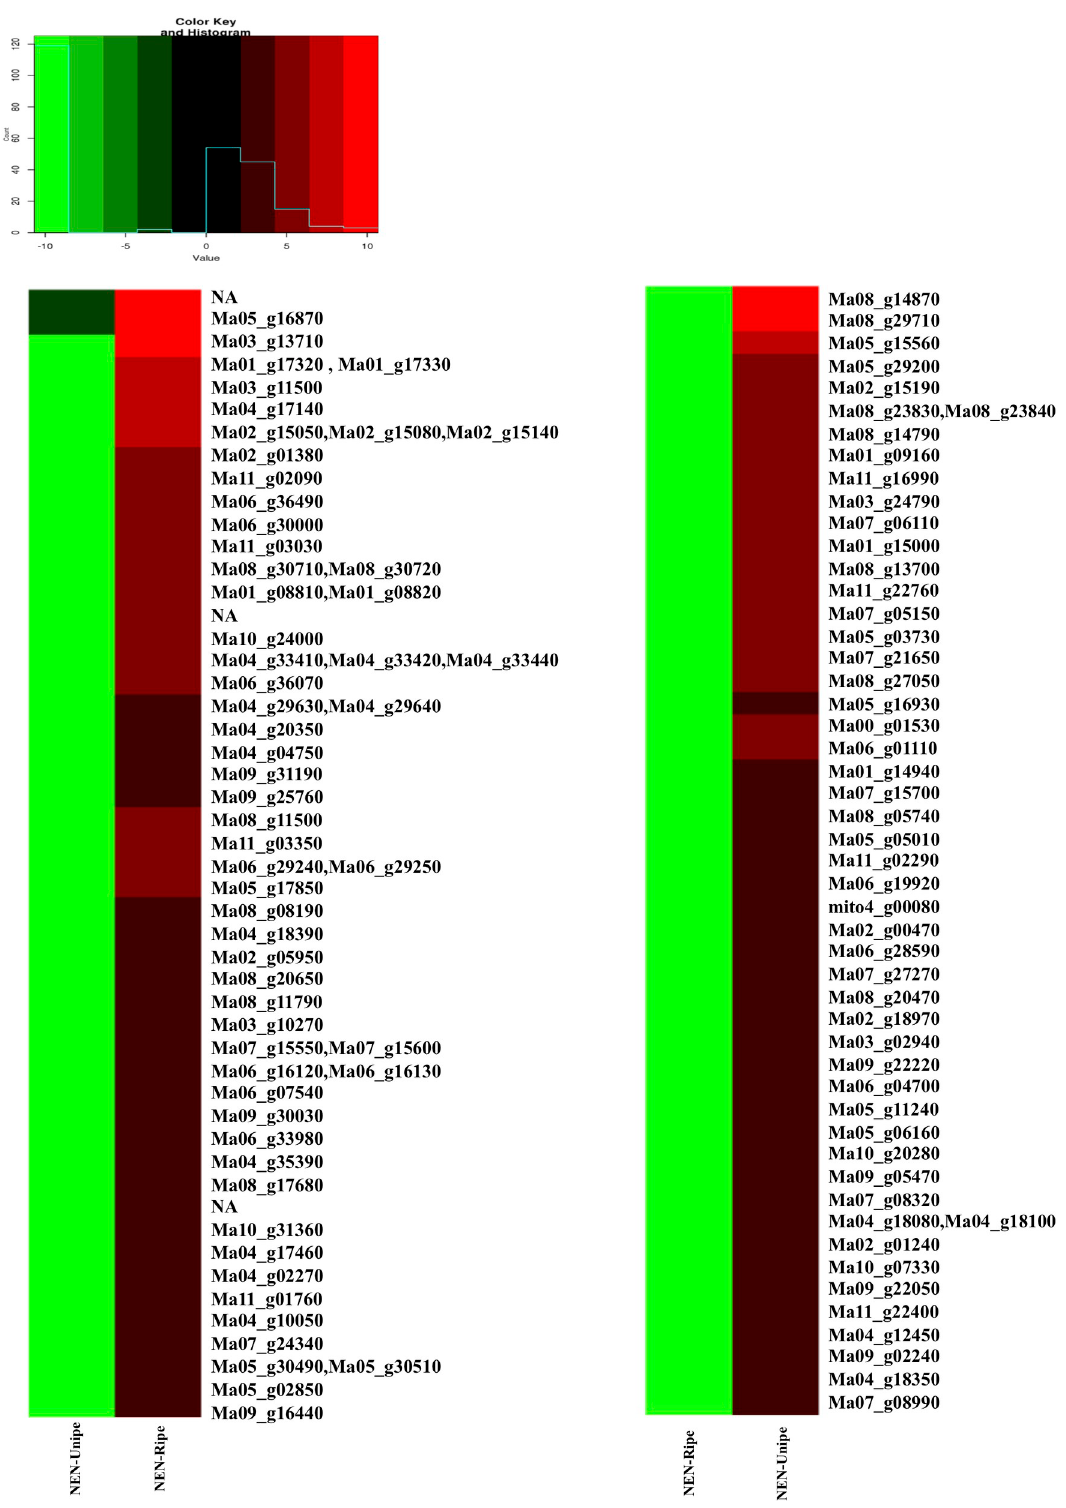
Fig 4. Clustered heatmap depicting top 50 up-regulated (left panel) and down-regulated genes (right panel) in ripe fruit pulp. Red color indicates up-regulated genes and green color indicates down-regulated genes in Nendran fruit samples.